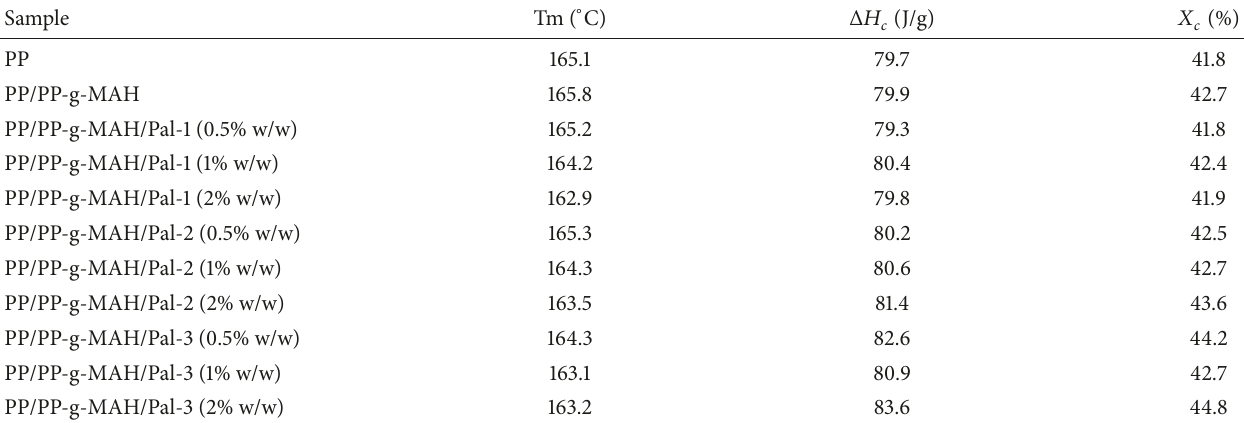
Table 2: DSC parameters for PP and PP/PP-g-MAH/Pal